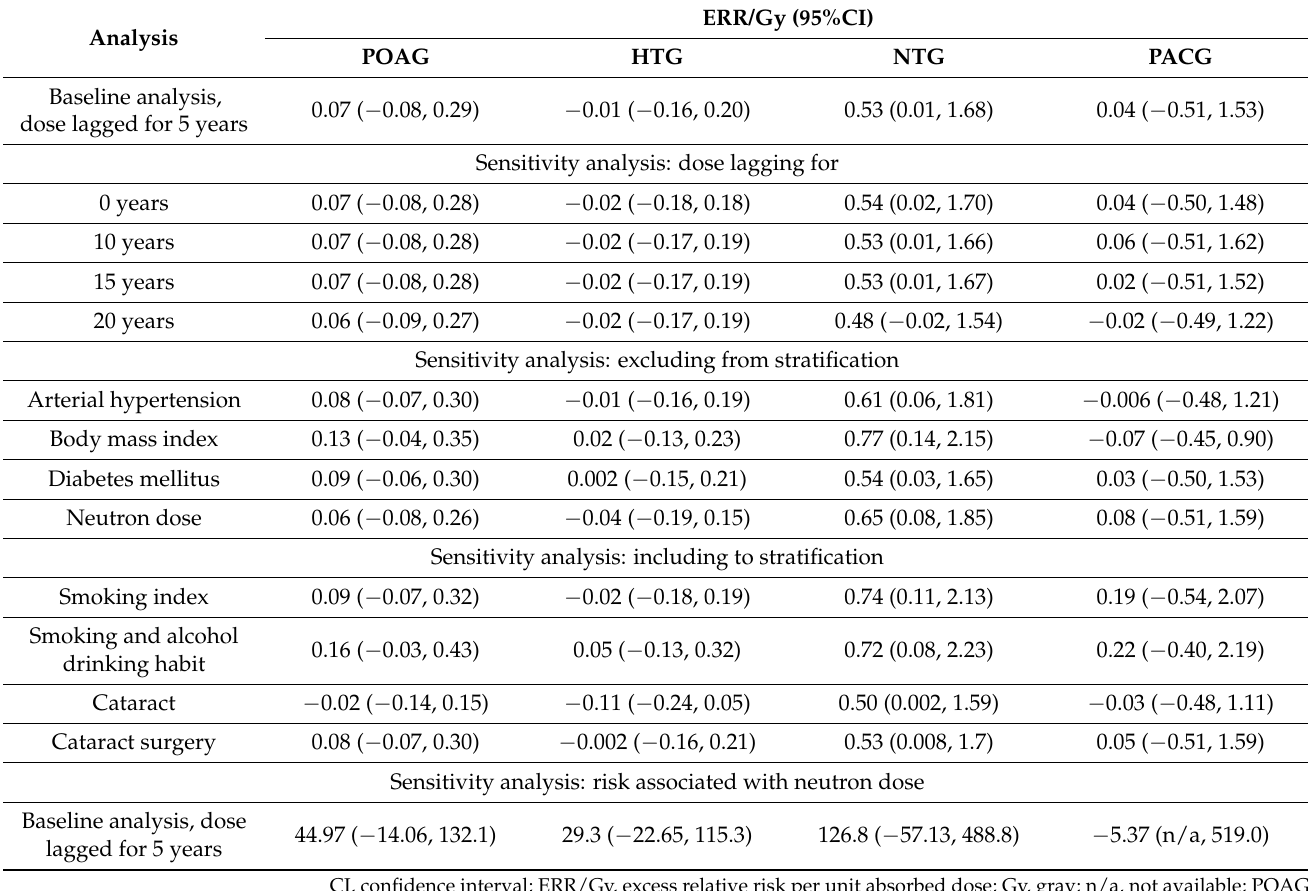
Table 4. Excess relative risks of various primary glaucoma type incidence in relation to cumulative brain absorbed dose of external gamma-ray and neutron exposure lagged for 5 years.